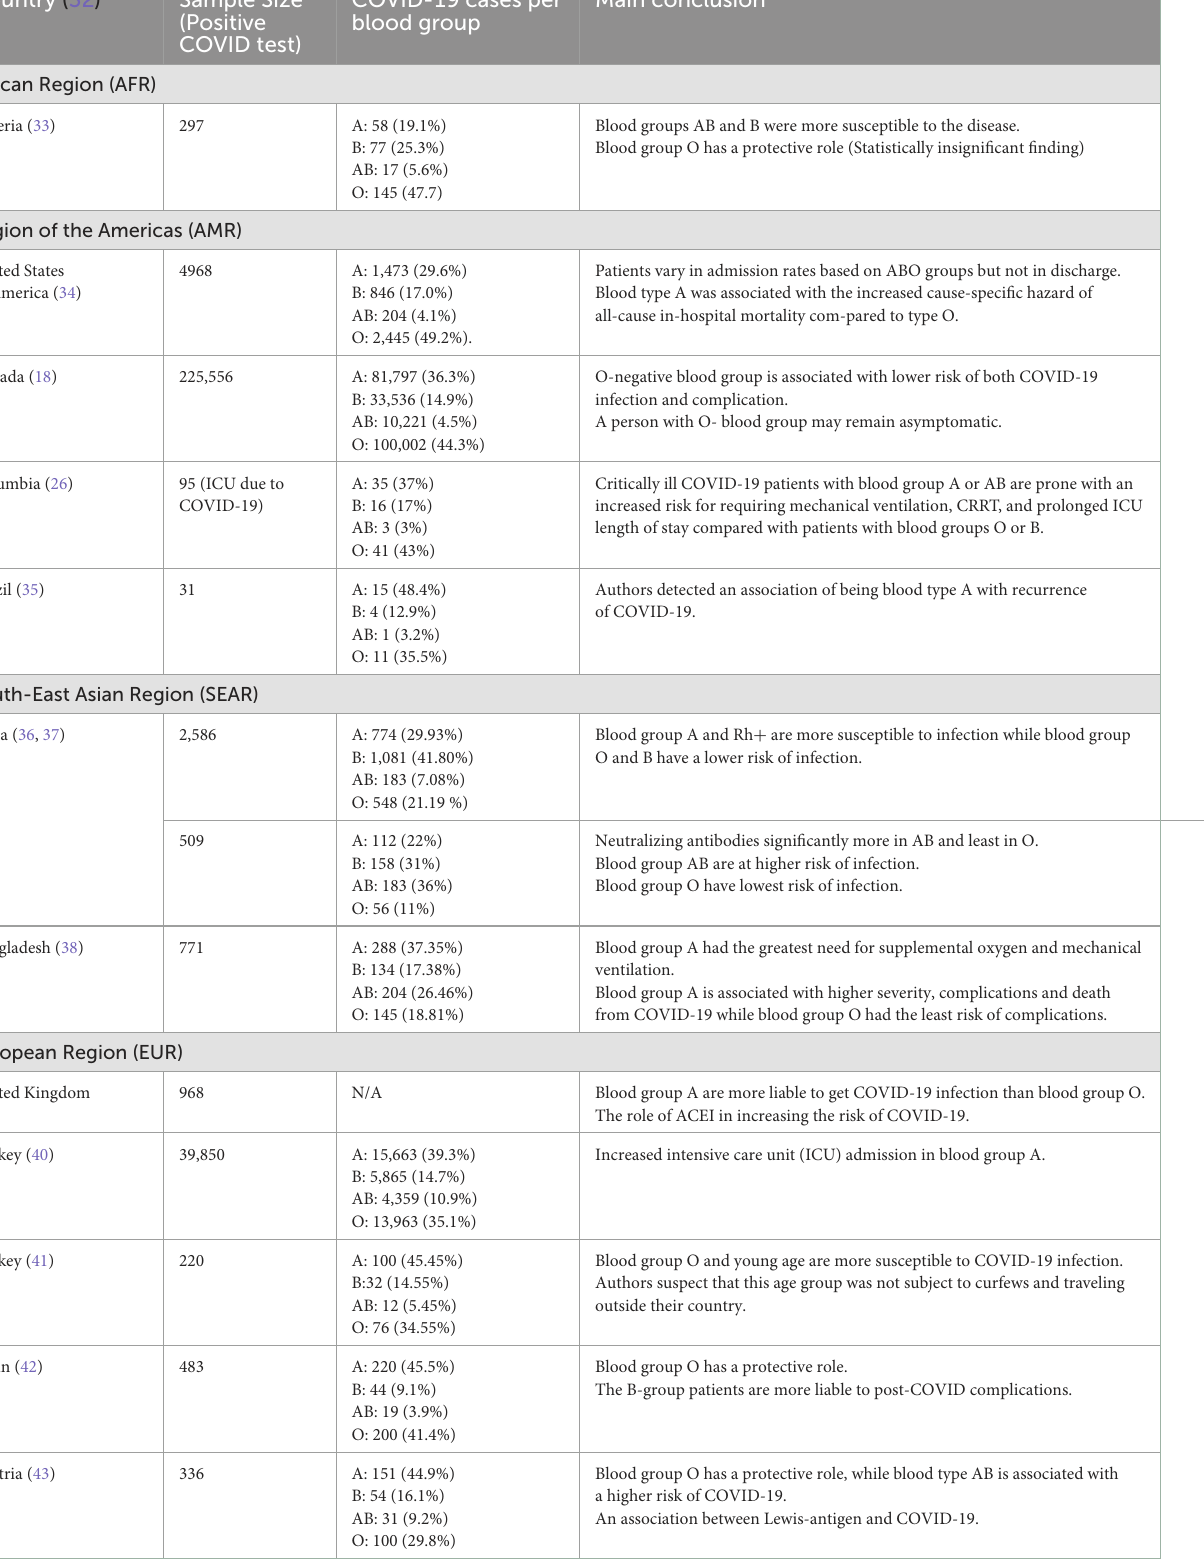
TABLE 1 A summary of population-based studies sampled from each region in the world. Country (32) Sample Size